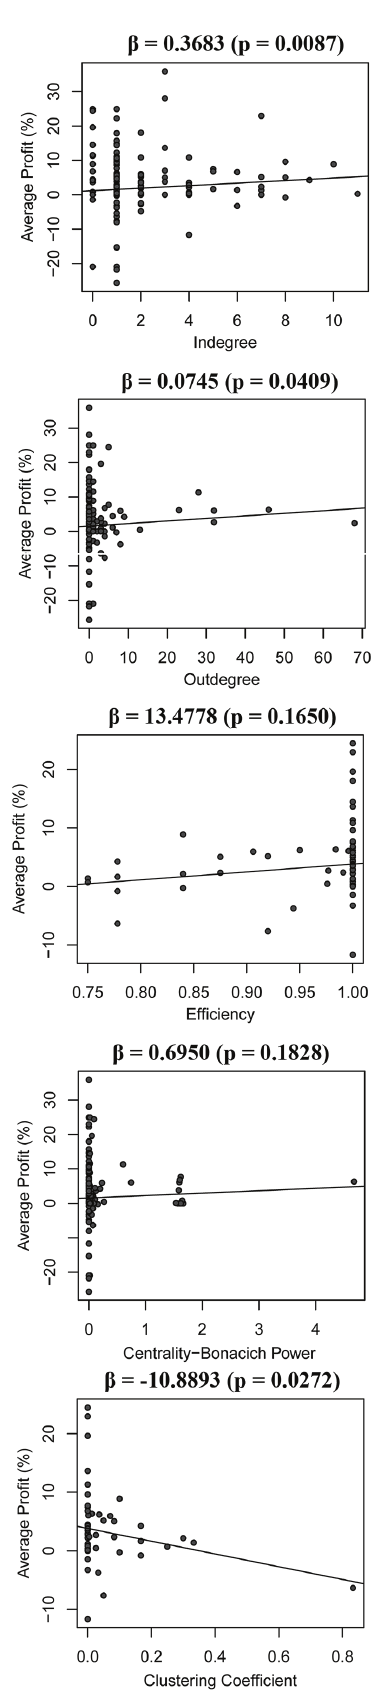
Fig. 7. Relation of firms’ average profit with network